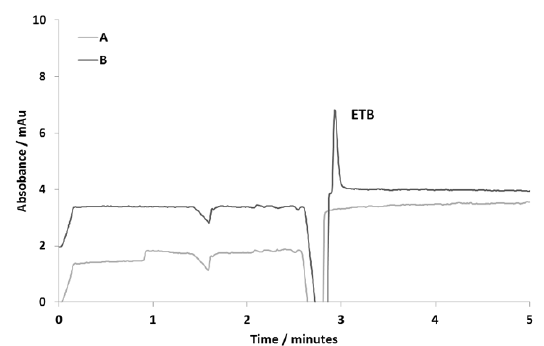
Figure 4. Electropherograms obtained for urine sample (A) without and (B) with addition of